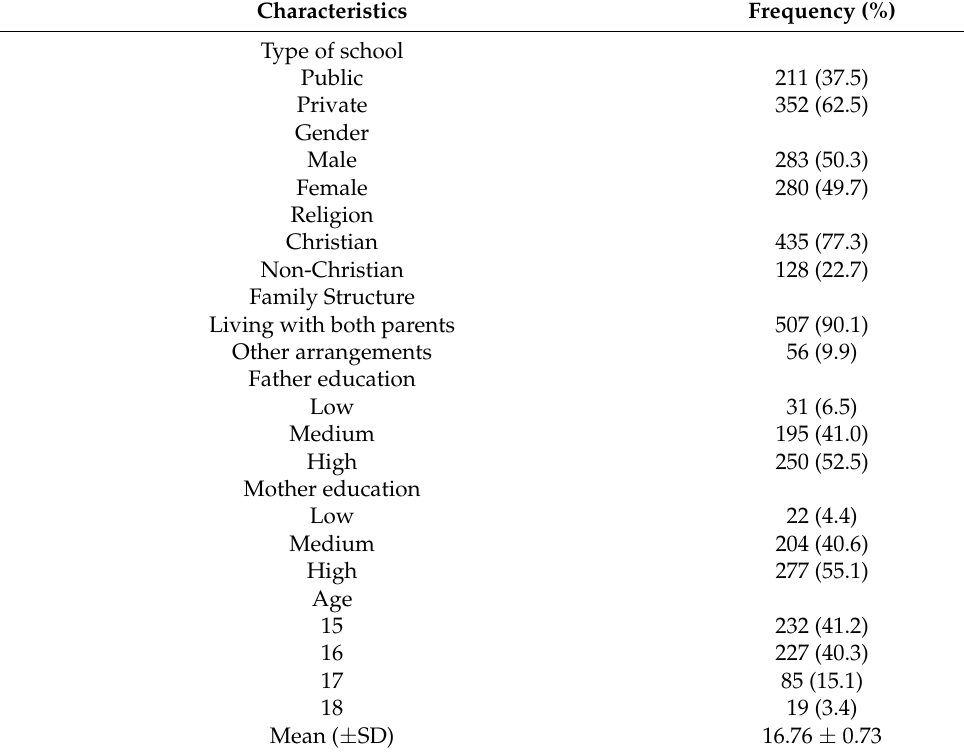
Table 1. Descriptive characteristics of the baseline sample (N =